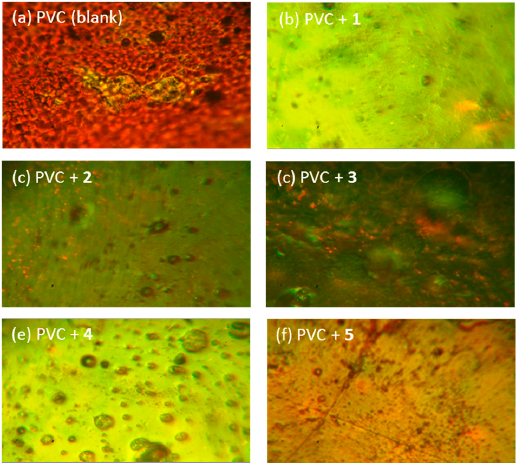
Figure 8. Microscope images for the irradiated (250 h) PVC films (30 μ m thickness) with Schiff’s bases 1 – 5 (0.5% by weight) as additives.